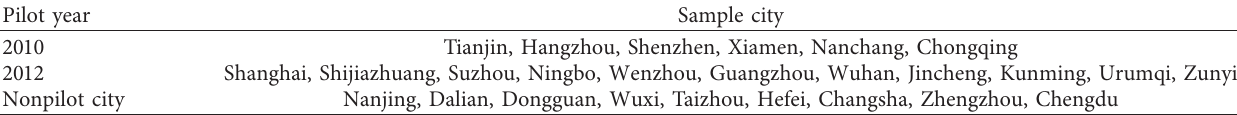
Table 1: List of sample cities (according to the official website of the National Development and Reform Commission).